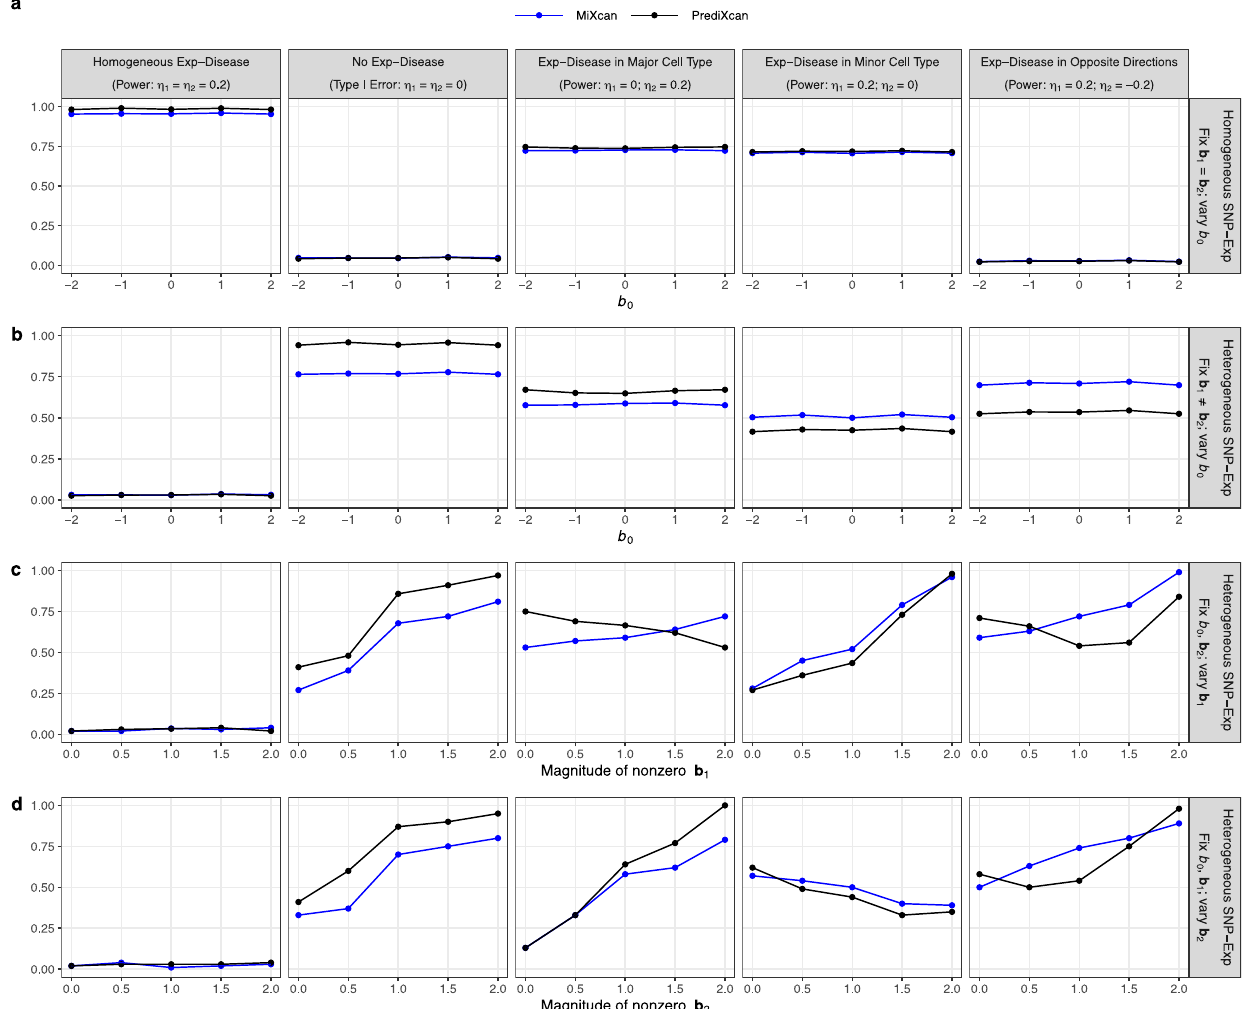
Fig.4|SimulationstudiestoevaluatethetypeIerrorandpowerofMiXcanand PrediXcan to detect associations of GReX with disease at the tissue level. Bulk tissue samples ( N =300) for training GReX prediction models and independent studies( N =3000)fortestingdiseaseassociationsweresimulatedunderarangeof realisticdatascenarios.Gene expressionlevelswere modeled by u = b 0 + b 1 x + e u in the minor cell type, v = b 2 x + e v in the major cell type, and y = π u +(1 − π ) v at the tissue level, where π denotes the minor cell-type proportion, b 0 denotes the mean differenceofthe gene expression levels in the two celltypes, and b 1 and b 2 denote the weights for the association of SNPs X with gene expression levels in the minor